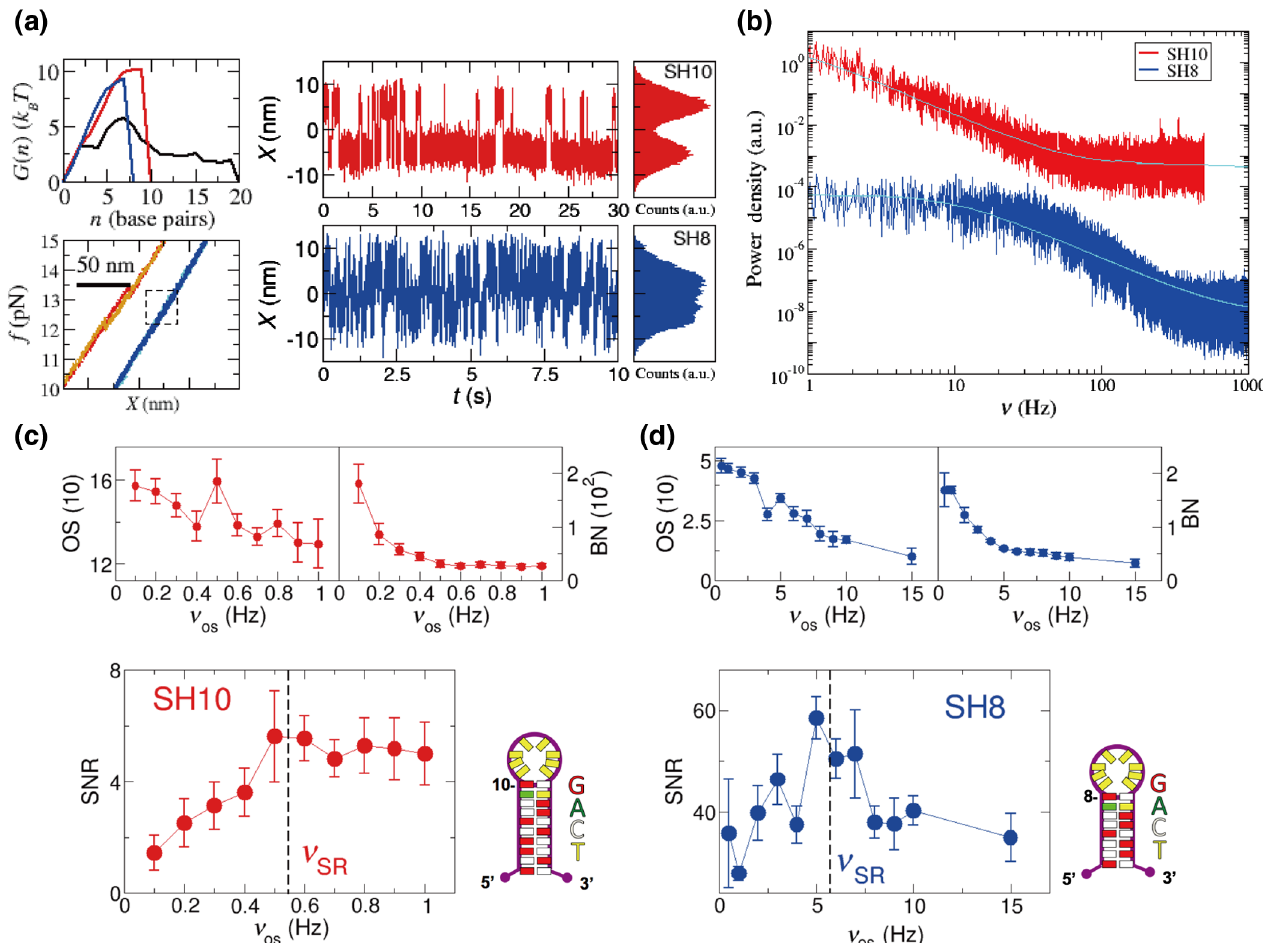
FIG. 5. SR experiments in shorter hairpins. (a) Free-energy landscapes (upper left), force-distance curves (lower left), and hopping traces in the CFM for SH10 (red), SH8 (blue), and H1 (black). Measurements have been carried out with a low trap power (cid:4) trap ’ 32 pN =(cid:5) m for SH10 and 17 pN =(cid:5) m for SH8, respectively. For simplicity, all pulling curves in the lower left panel are shown parallel with equal average slopes. The dashed square region for SH8 curves indicates the region where unfolding and folding transitions occur. Distributions of trap position, X , show clear transitions for SH10 but not for SH8. (b) Power spectrum for SH10 and SH8. Cyan curves are fits to a sum of two Lorentzians (see text for details). Colors mean the same as in (a). (c),(d) OS, BN, and SNR for SH10 and SH8. The amplitudesofoscillationforceare A ¼ 0 : 5 pN forSH10and A ¼ 0 : 15 pN forSH8,respectively.Colorsmeanthesameasin(a).Statistics (SH10, SH8): molecules (5, 7); duration of hopping traces (4, 2 minutes); average number of hopping transitions (250, 1200) at each input frequency. Units: OS ( nm 2 ), BN ( nm 2 = Hz ), SNR (Hz). The error bars represent the standard errors over different